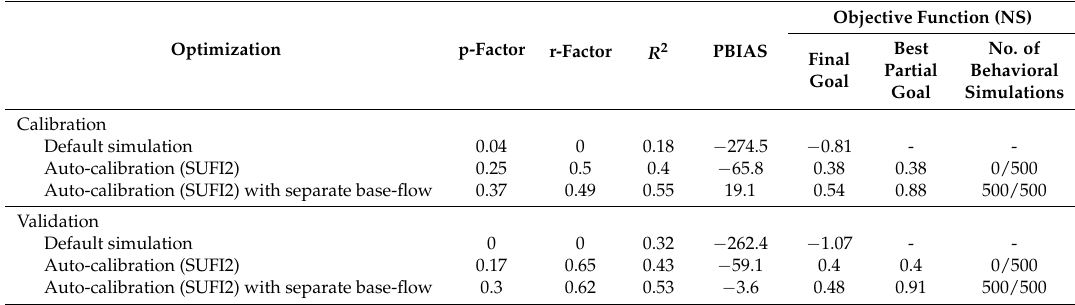
Table 2. SWAT model performance on a daily time step for the Kersbrook catchment using modified NS objective function (with separate base-flow).